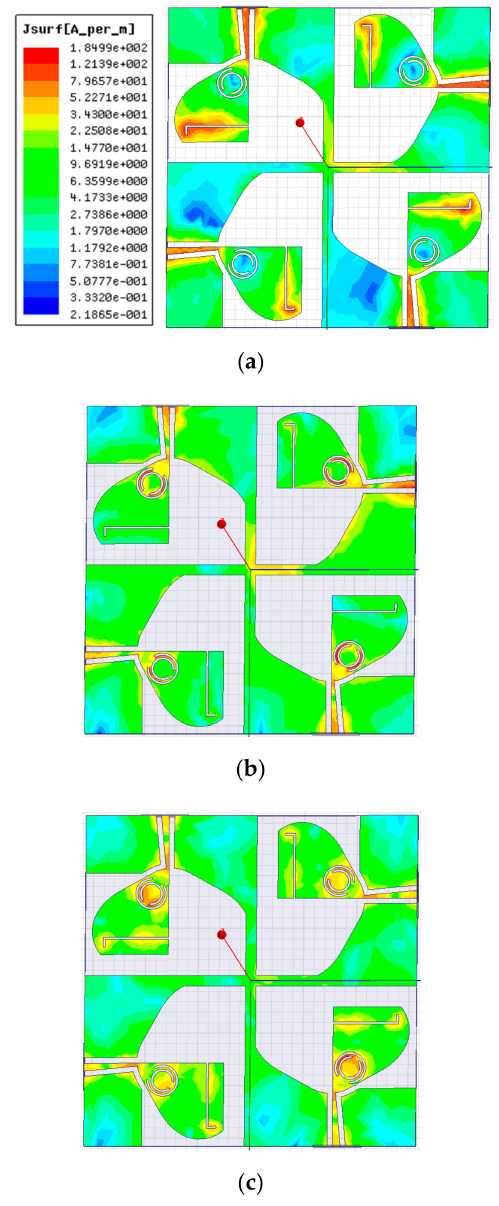
Figure10. SimulatedsurfacecurrentdistributionsoftheMIMOantennaat( a )3.5; ( b )5.5; and( c )8.5GHz.